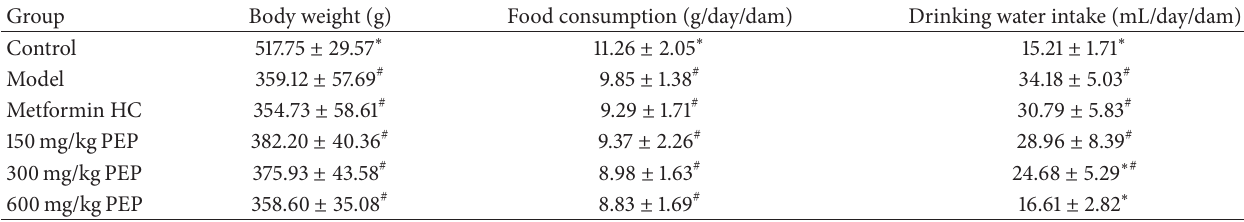
Table 1: The effect of PEP on body weight, food consumption, and drinking water intake in DM rats.